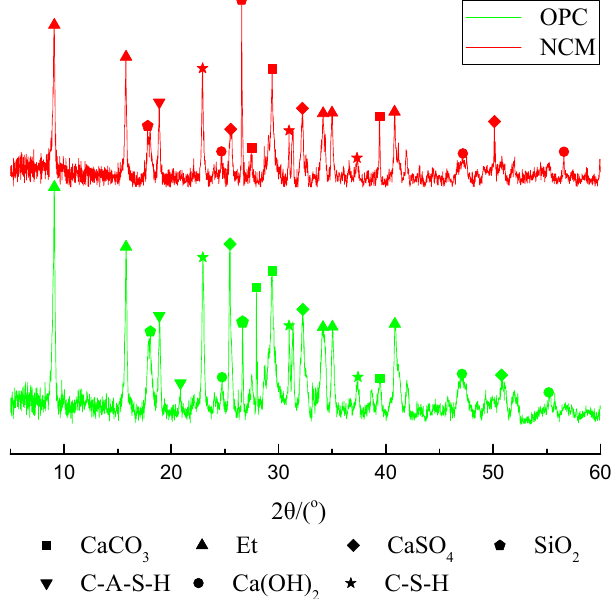
Figure 6. XRD images of NCM and OPC for 7 days of curing time (NCM: new cement-based material; OPC: ordinary Portland cement).